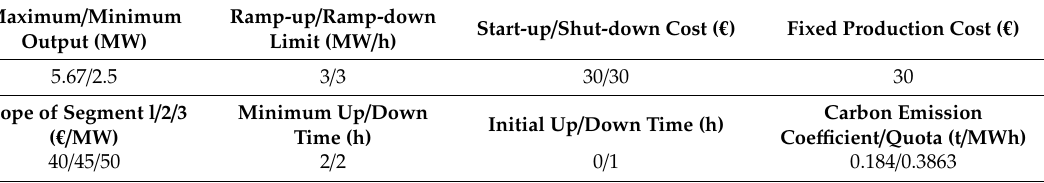
Table A1. Parameters of the TAU5670 gas turbine.